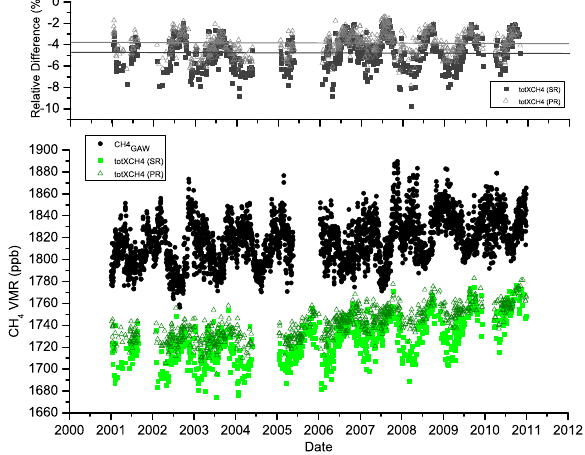
Fig. 5. CH 4 in-situ (black circles) and totXCH 4 FTIR data GAW obtained from scaling (squares) and profiling (triangles) retrieval, respectively. Bottom panel: 2001–2010 time series for all avail- able data; top panel: time series of the difference expressed as (FTIR − GAW)/GAW for the scaling (squares) and profiling (trian- gles) retrieval, respectively. The solid lines represent the mean rela- tive difference for the scaling and profiling retrieval, respectively.